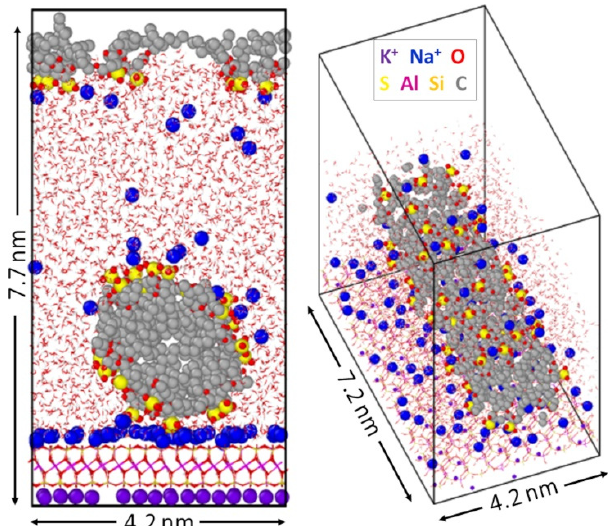
Figure 1. Snapshot from MD simulation of a 32 AOT system at 300 K with sodium counterions showing an adsorbed cylindrical AOT micelle in the yz plane (left) and a rotated view (right). The simulation cell boundaries are shown as black lines along with approximate cell dimensions. The mica layer is shown as sticks (red = O, dark yellow = Si, magenta = Al), AOT anions as spheres (red = O, gray = C, yellow = S), aqueous cations as large spheres (purple = K + , blue = Na + ), and water atoms as red sticks. Hydrogen atoms in the mica layer and AOT anions have been omitted for clarity.